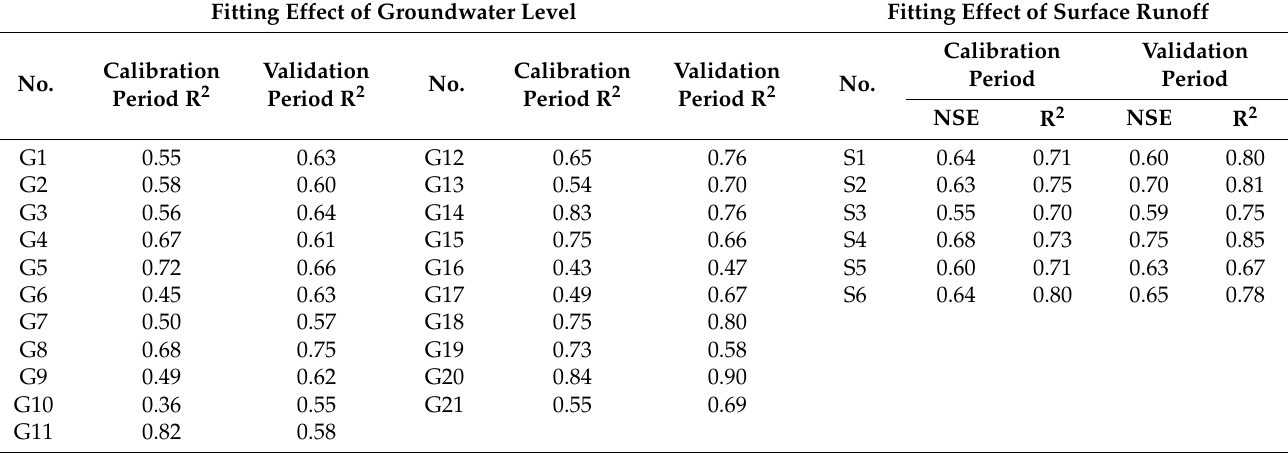
Table 3. NSE and R 2 at representative observation wells and hydrological stations. The locations of wells and stations can be found in Figure